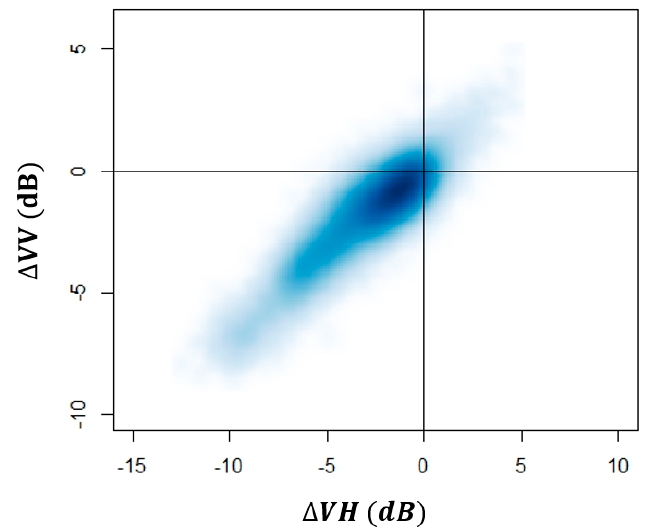
Figure 7. Density plot showing the variability of pre-fire to post-fire backscatter di ff erences ∆ VV and ∆ VH for all burn records (N=106,000) measured in the 30 KNP burn events in 2015. The blue shade is indicative of record density from low (light blue) to high (dark blue).